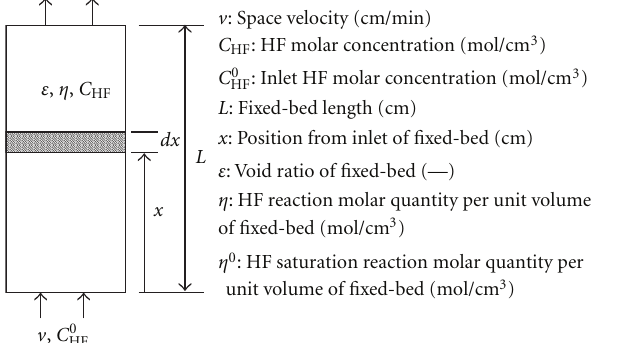
Figure 3: Description of material balance of fixed-bed reaction furnace.